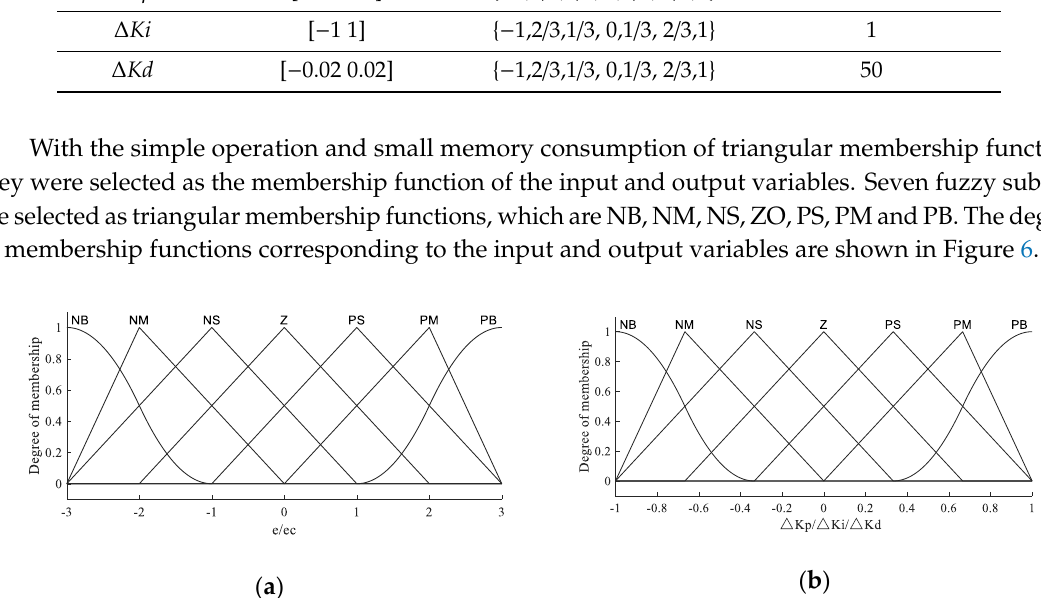
Figure 6. Input and output variable membership function: ( a ) Membership function of the input variables e , ec ; ( b ) membership function of the output variables Δ K p , Δ K i , andΔ K d .